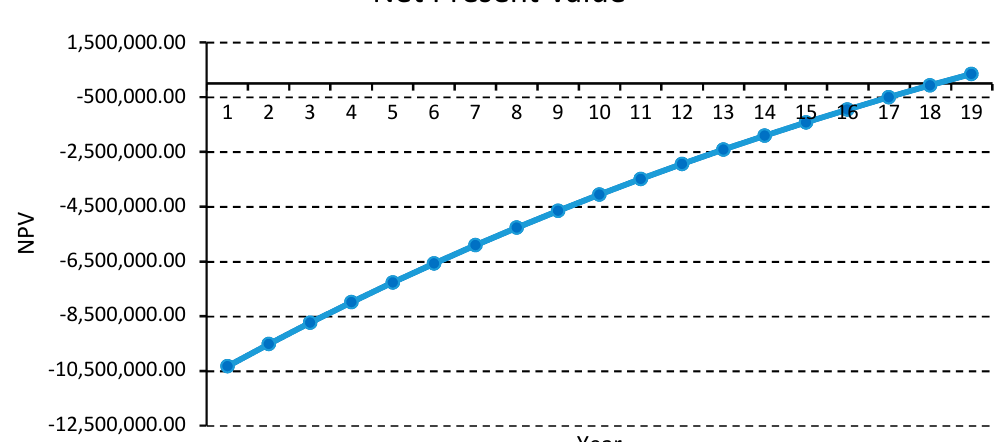
Figure 10. Net present value diagram.